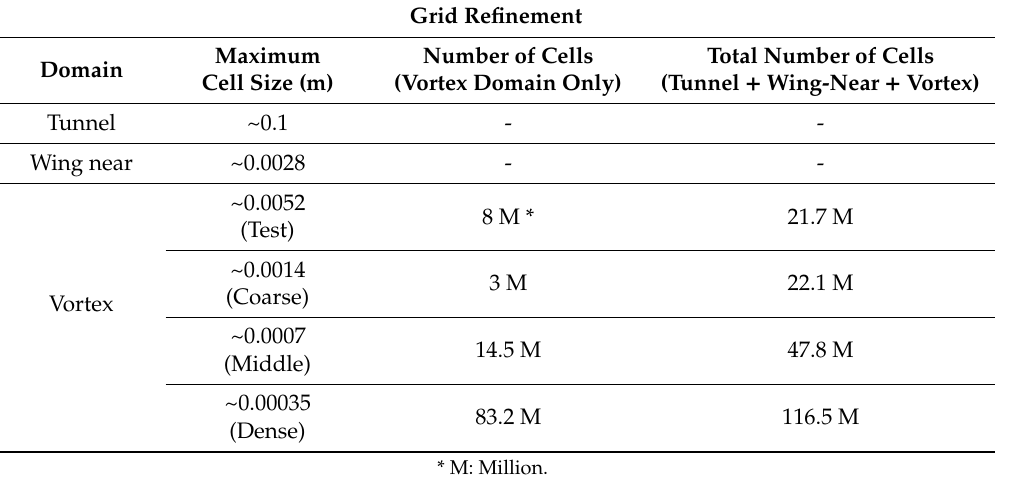
Table 1. Grid refinement in vortex domain.